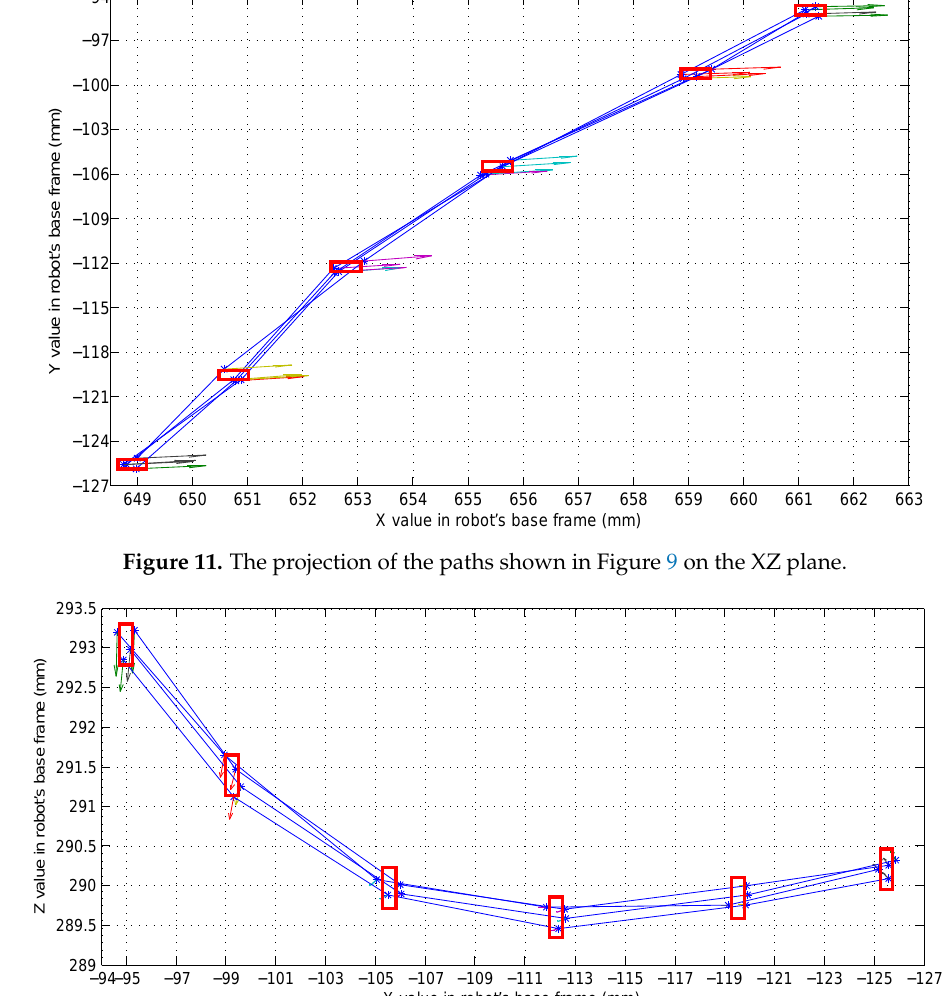
Figure 12. The projection of the paths shown in Figure 9 on the YZ